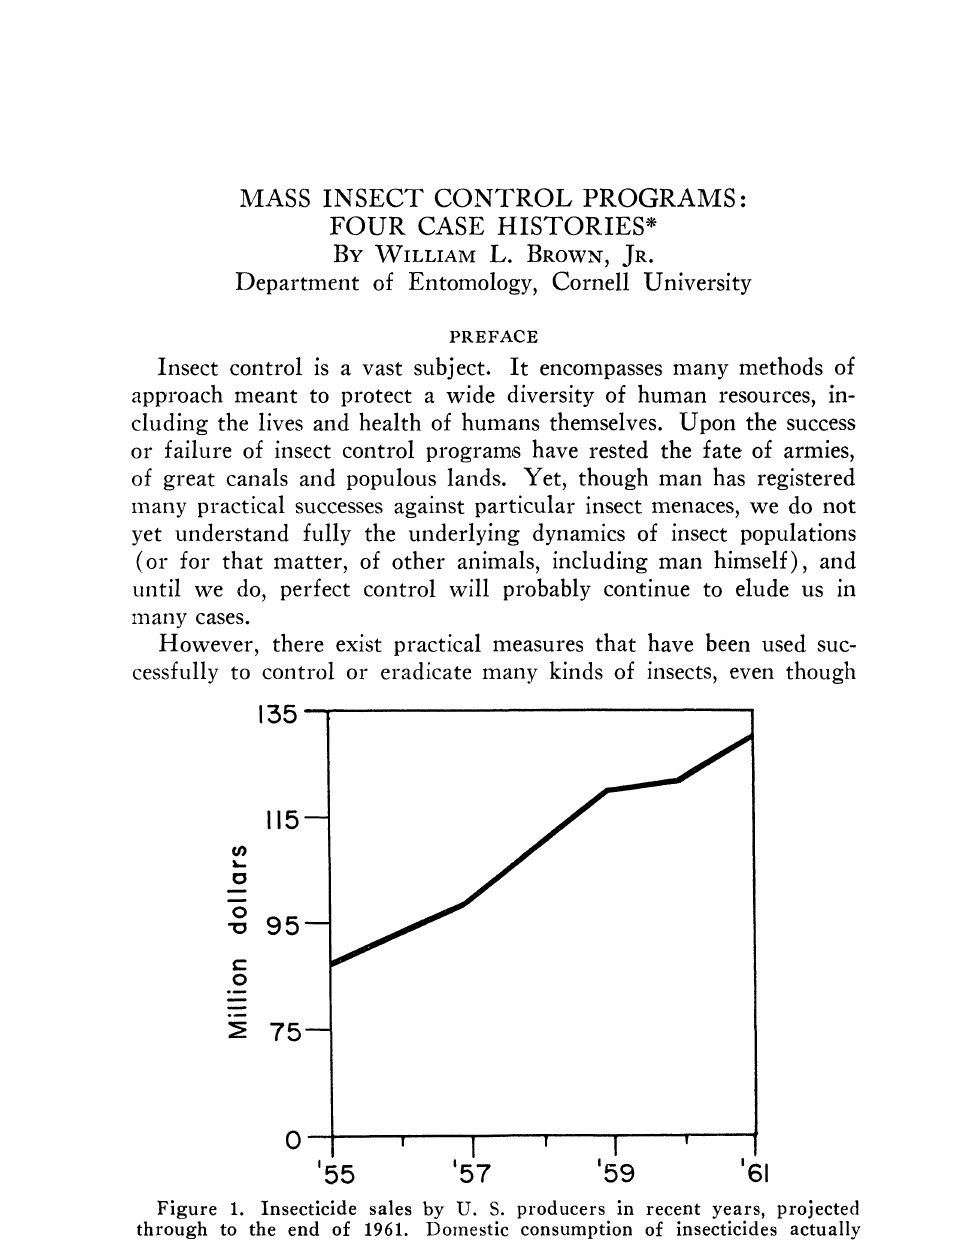
Figure 1. Insecticide sales by U. S. producers in recent years, projected through to the end of 1961. Domestic consumption of insecticides actually declined slightly during 1960 in the U. S., but exports more than made up this dip. From Chemical Week, July 22, 1961, by permission. *This study and the report were sponsored and supported by the Conserva- tion Foundation, New